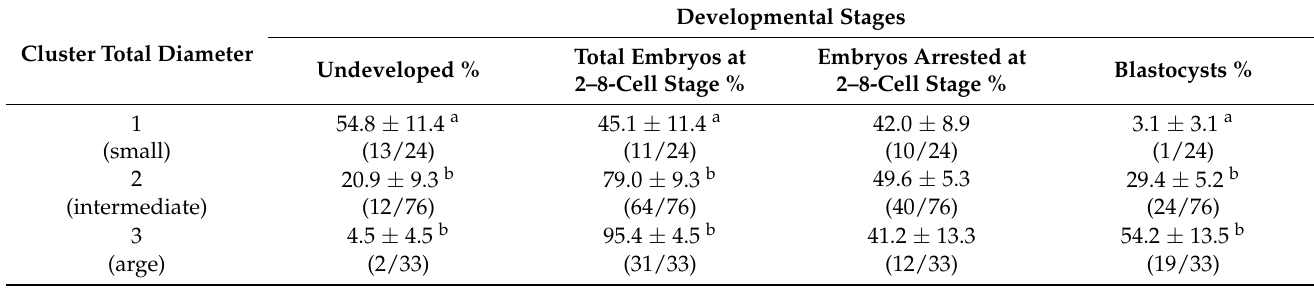
Table 4. Mean values of different developmental stages by clustering of morphometric parameters of oocyte by total diameter.